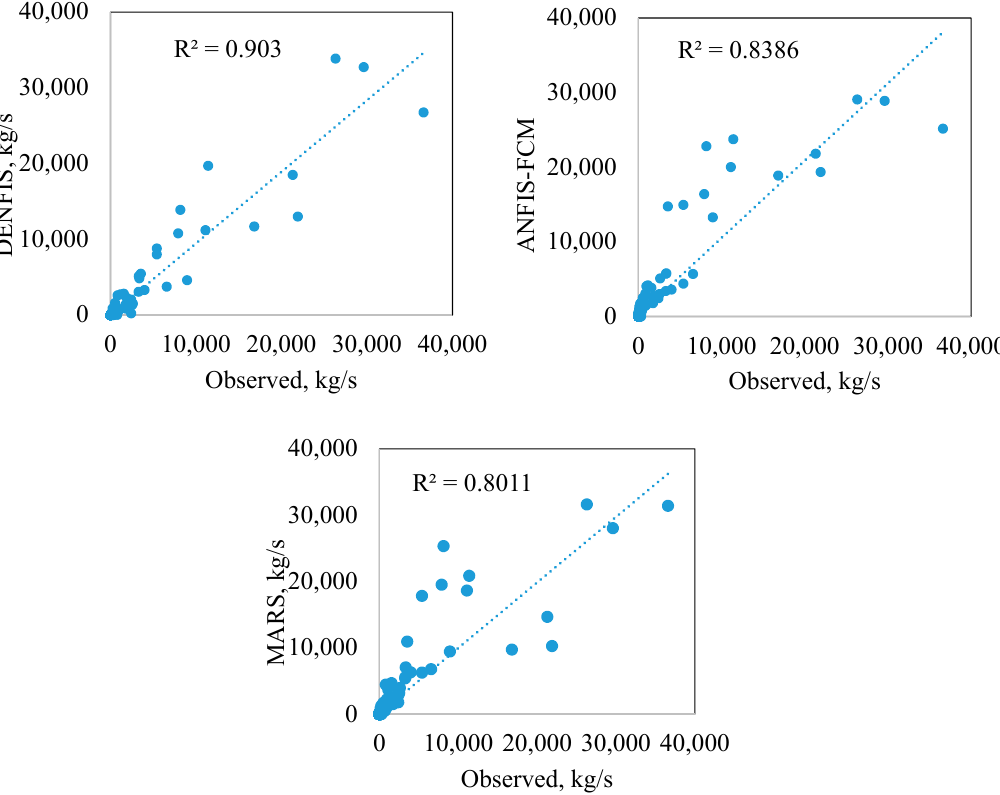
Figure 8. Time scatterplots of the observed and estimated suspended sediment by DENFIS, ANFIS-FCM and MARS in the test period at Beibei Station.